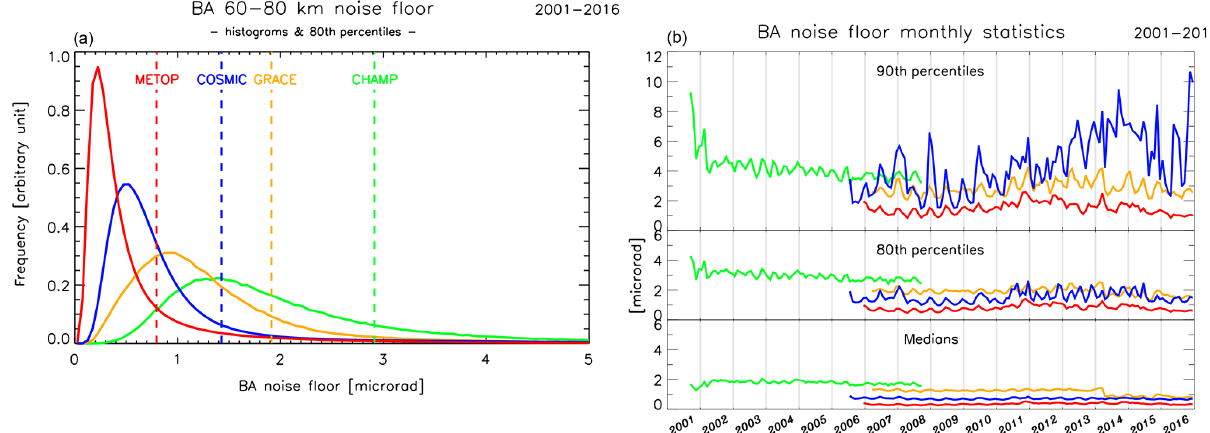
Figure 2. Bending angle (BA) noise floor for the four RO missions (CHAMP, GRACE, COSMIC, and Metop): overall distributions (a) and the time evolution of the associated medians, 80th, and 90th percentiles (b) . The statistics include all data, including those that are rejected in the quality